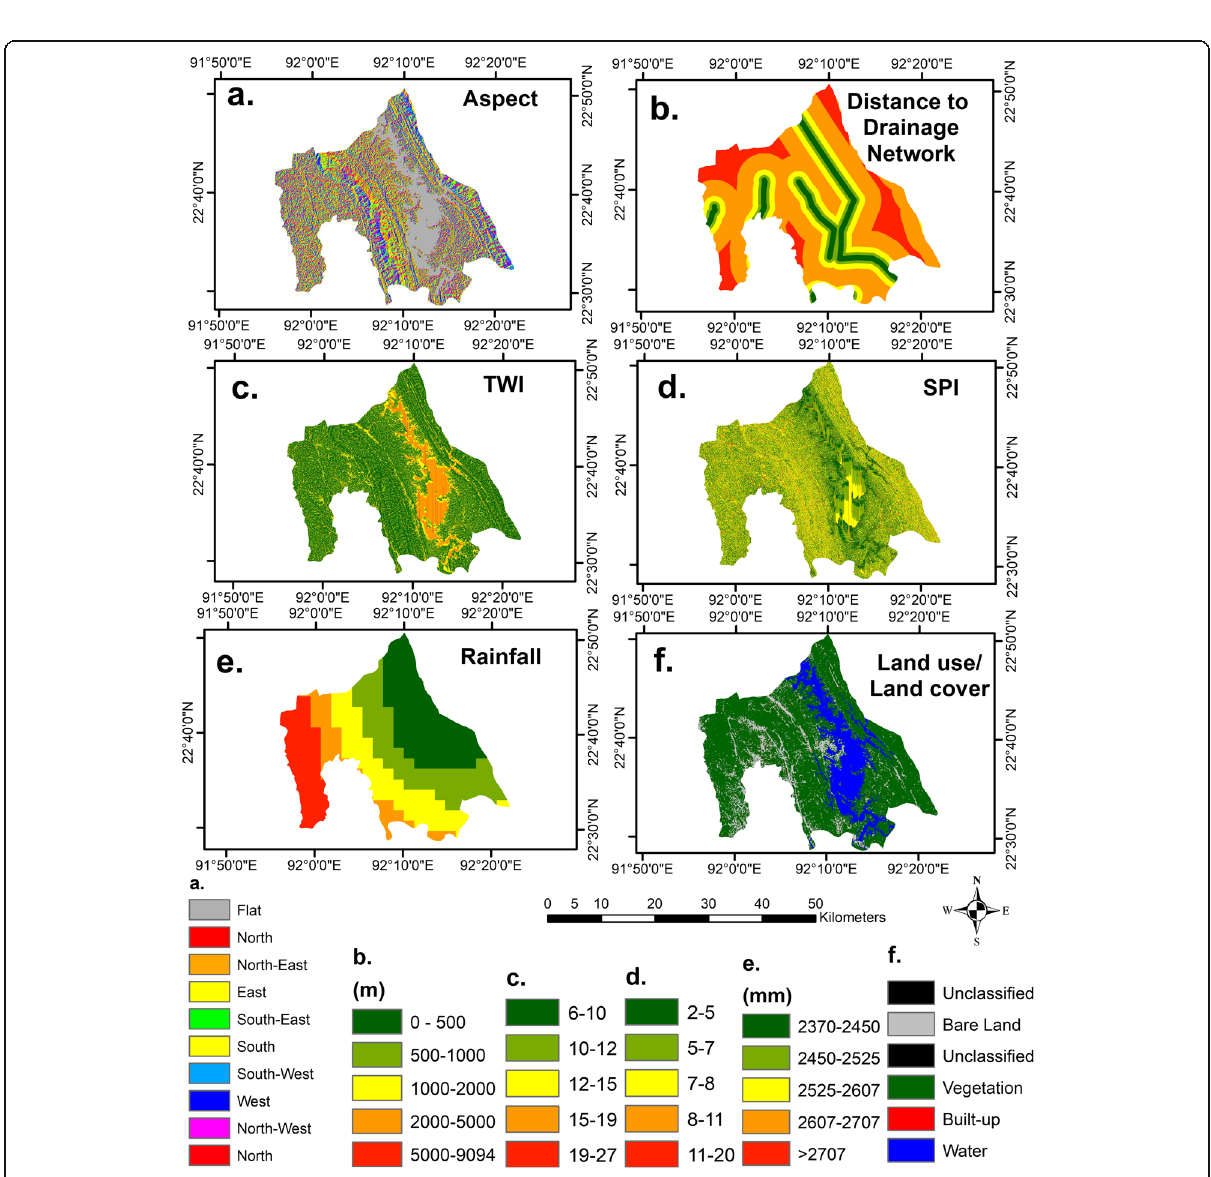
Fig. 4 Landslide Causative Factors: a . Aspect; b . Distance to Drainage; c . TWI; d . SPI; e . Rainfall; f . Land use/Land